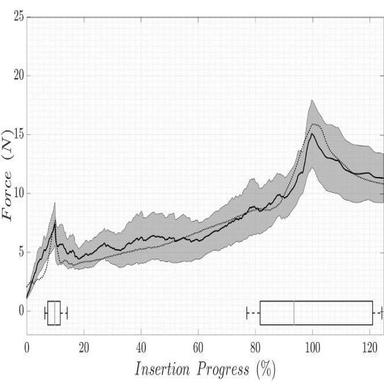
Black line: mean insertion force for human specimens, grey: � one standard deviation; black dotted line: mean insertion force for patient phantom. The insertion progress reaches 100% at the peak location when penetrating the lig. flavum; Horizontal boxplots show the variation of peak locations for human specimens.